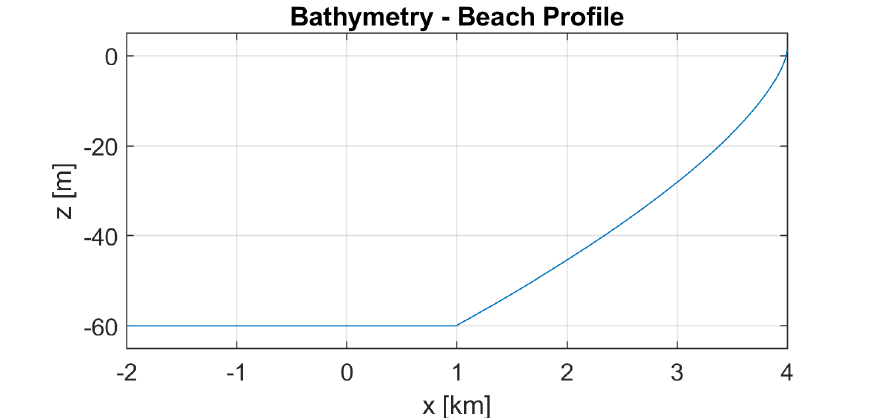
Figure 5. The bathymetry modeled in the study consisted of a flat bottom in the region of the WEC array (WEC array centered at x = 0), and an idealized beach profile [29] in the